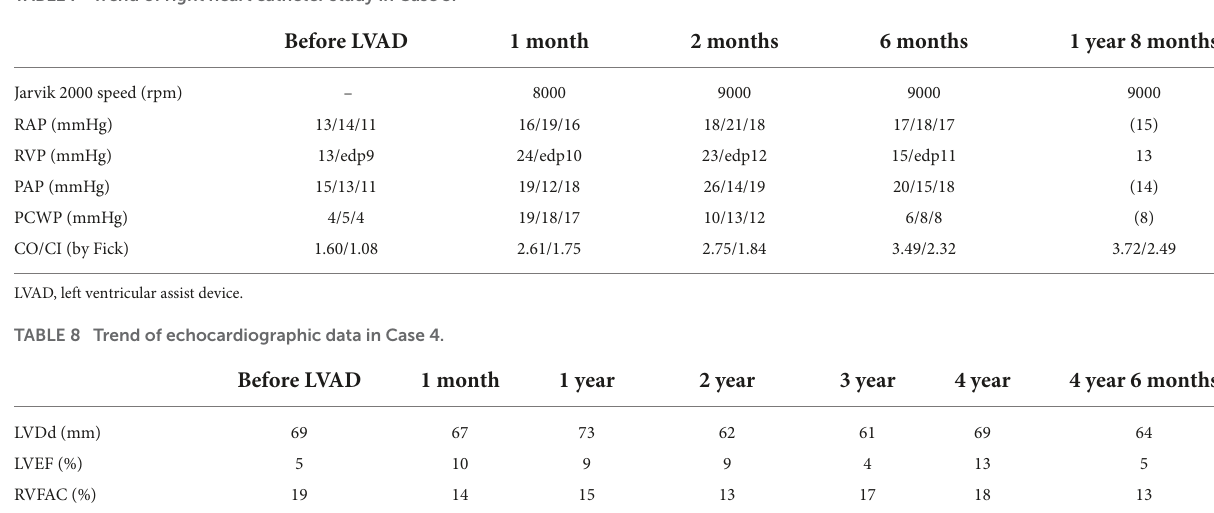
TABLE 7 Trend of right heart catheter study in Case 3.